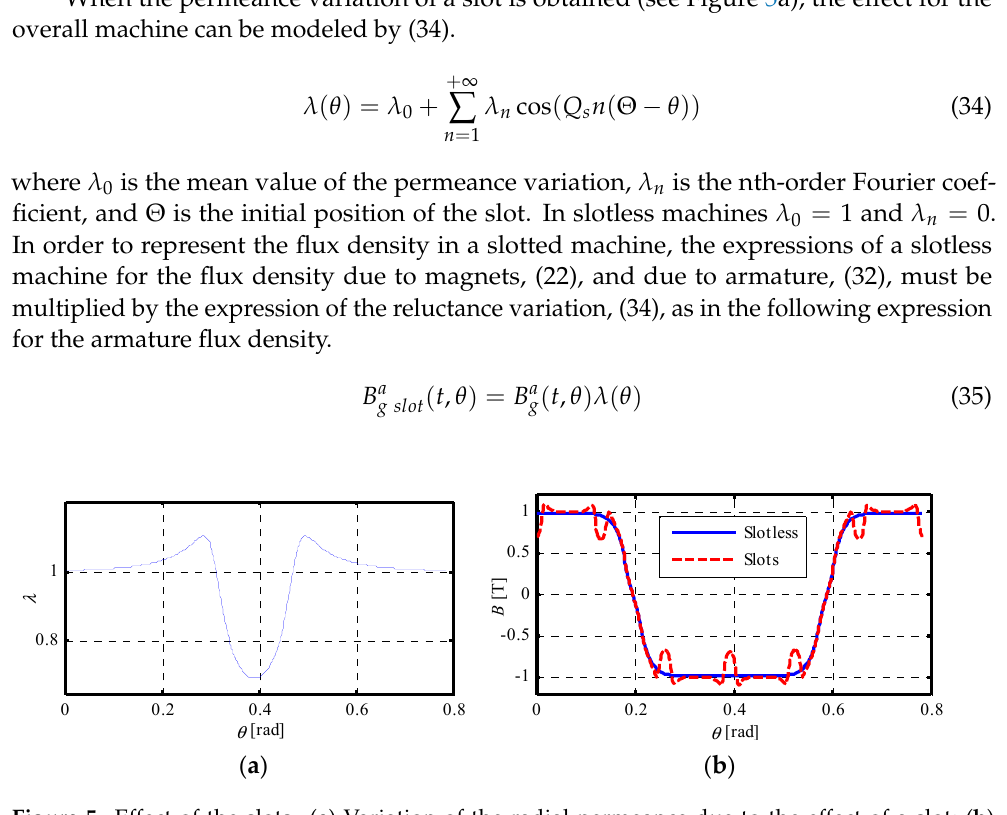
Figure 5. Effect of the slots. ( a ) Variation of the radial permeance due to the effect of a slot; ( b ) magnetic field in slotless and slot